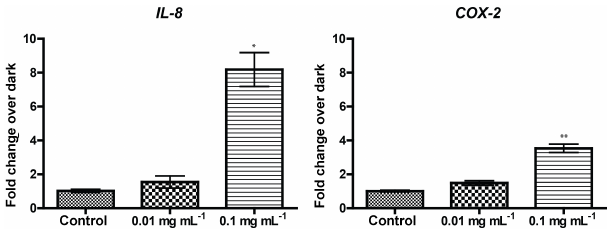
Figure 5. IL-8 and COX-2 expression induced by exposure to isoprene-derived SOA using resuspension method all normalized to dark control experiments and against the housekeeping gene, β -actin. All experiments conducted in triplicate. ∗ p < 0.05 and ∗∗ p <